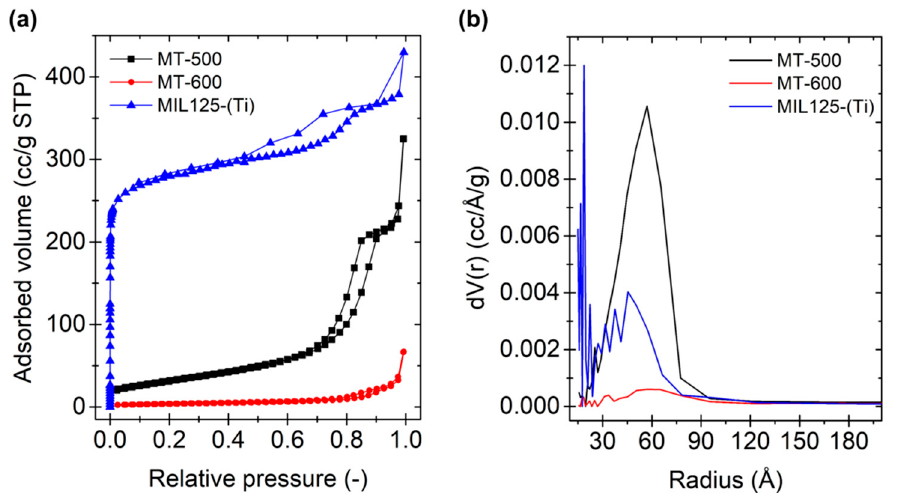
Figure 2. ( a ) TGA profile of MIL125 ‐ (Ti) in inert atmosphere (N 2 ) along the DTG signal; ( b ) TGA profiles of MIL125 ‐ (Ti), MT ‐ 500 and MT ‐ 600 in air.